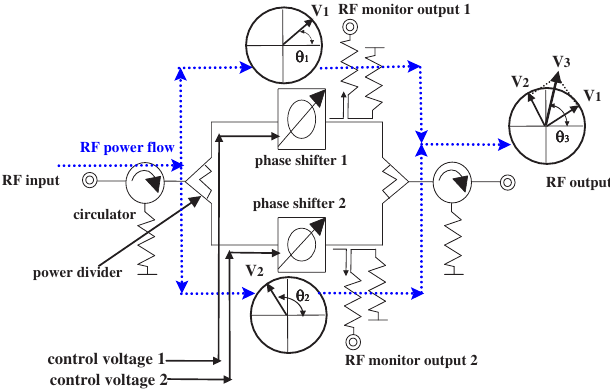
FIG. 2. (Color) Block diagram of the (cid:1)(cid:2) - A modulator.